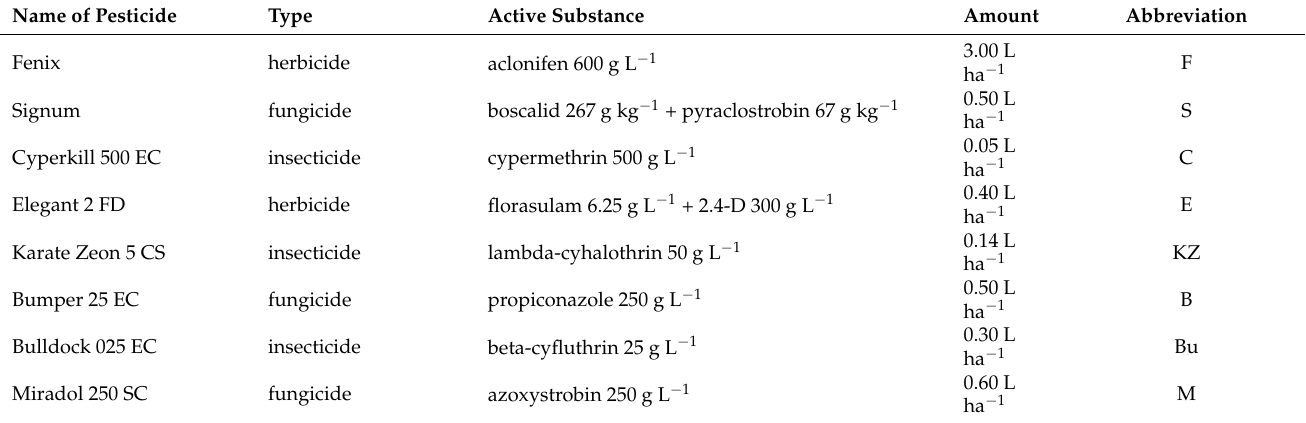
Table 5. Scheme for the use of pesticides in the